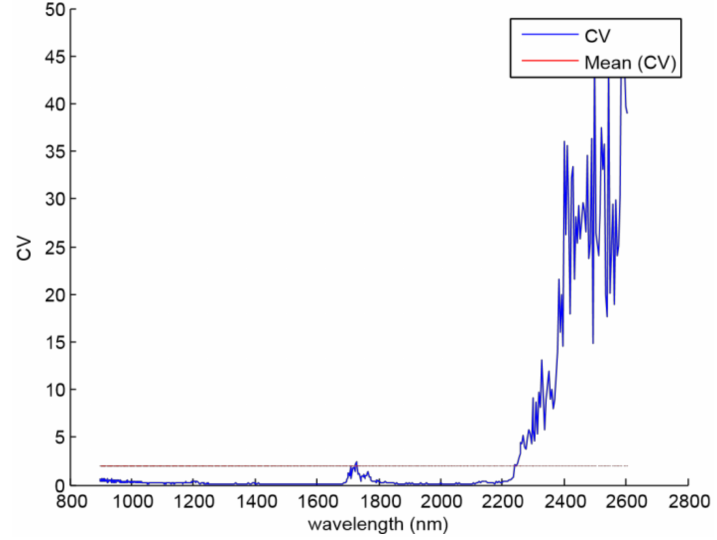
Figure 4. Blue line represents the CV coefficients for each wavelength; red line is the CV mean